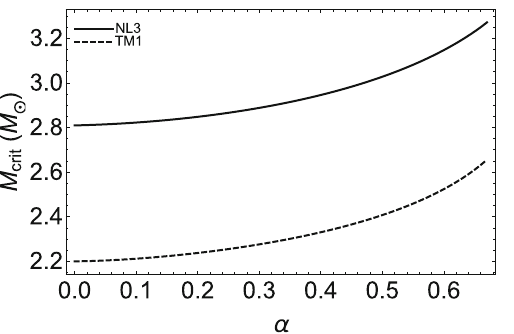
Fig. 7 Luminosity of GRB 180720B in the cosmological rest-frame of the source. Blue circles: obtained from Fermi -GBM in the 10 keV– 10 MeV energy band. The light grey parts represent the UPE phase; UPE I from t rf = 4 . 84 s to t rf = 6 . 05 s, and UPE II from t rf = 9 . 07 s to t rf = 10 . 89 s. The rest-frame luminosity light-curve of GRB 180720B during the UPE phase is fitted by a power-law with slope of α = 0 . 36 ± 0 . 23 and, amplitude of ( 1 . 21 ± 0 . 70 ) × 10 53 erg s − UPE